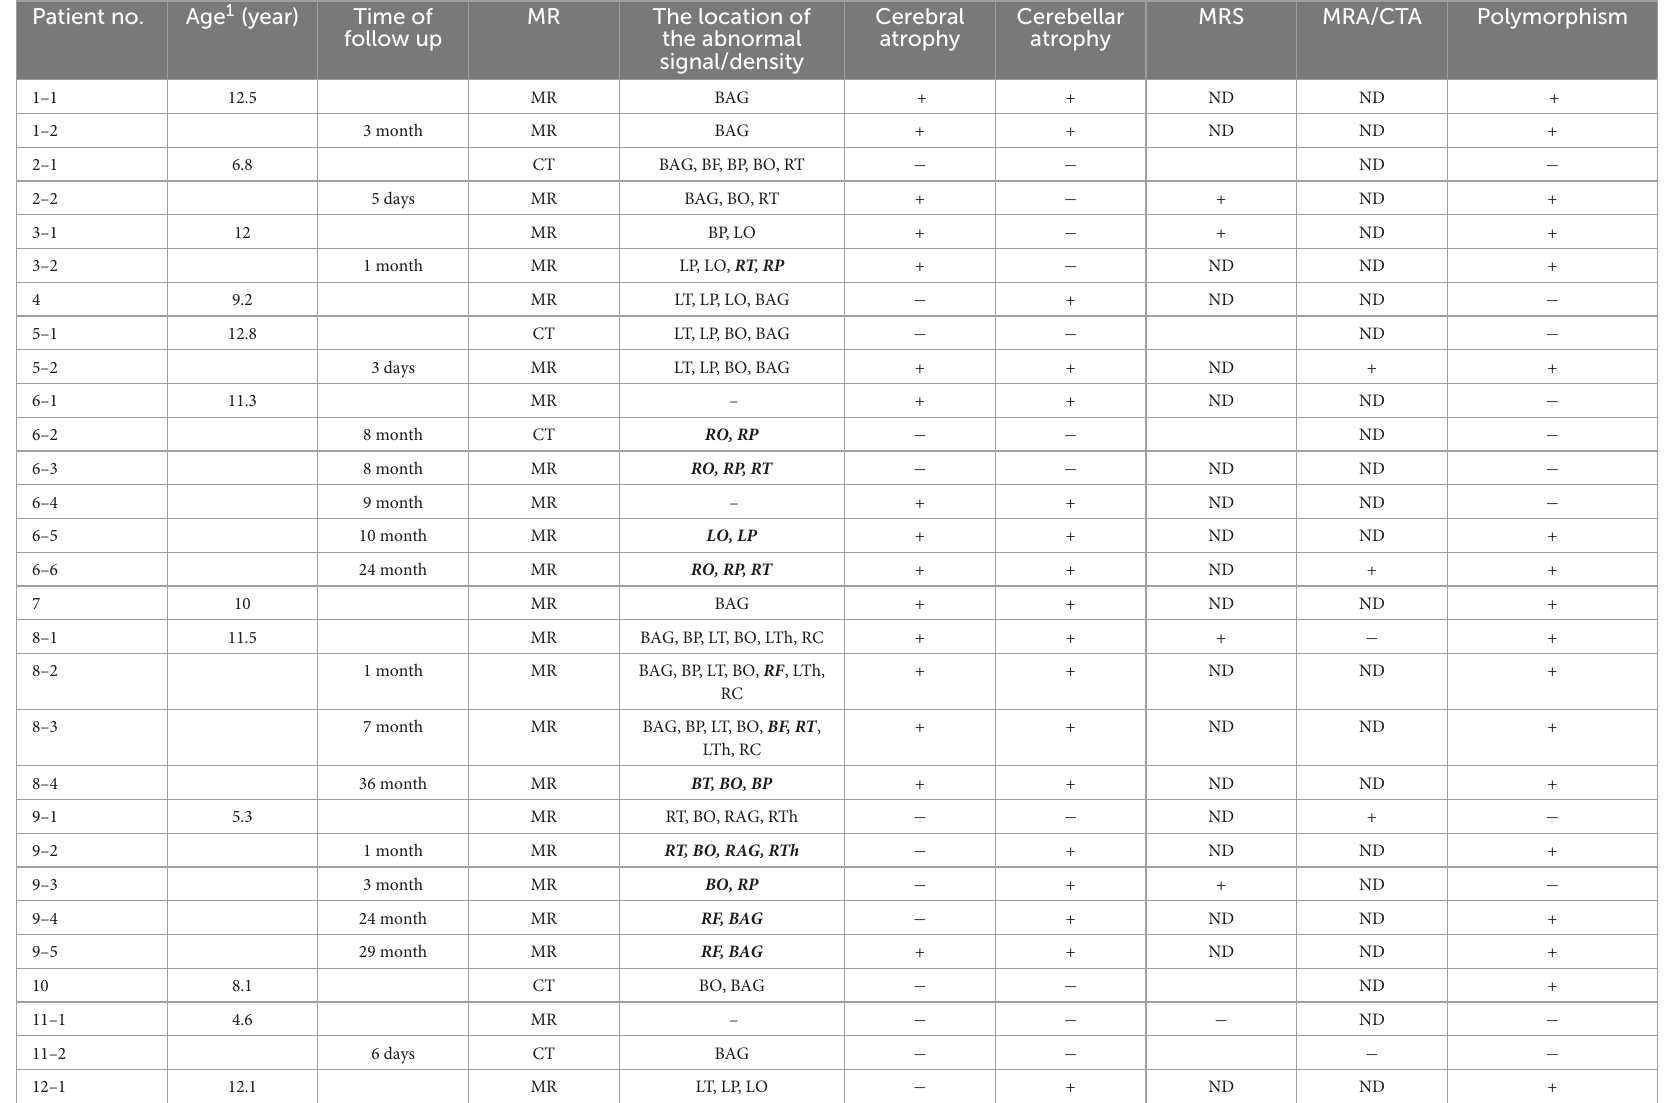
TABLE 2 Neuroradiological presentation and temporal evolution. Patient